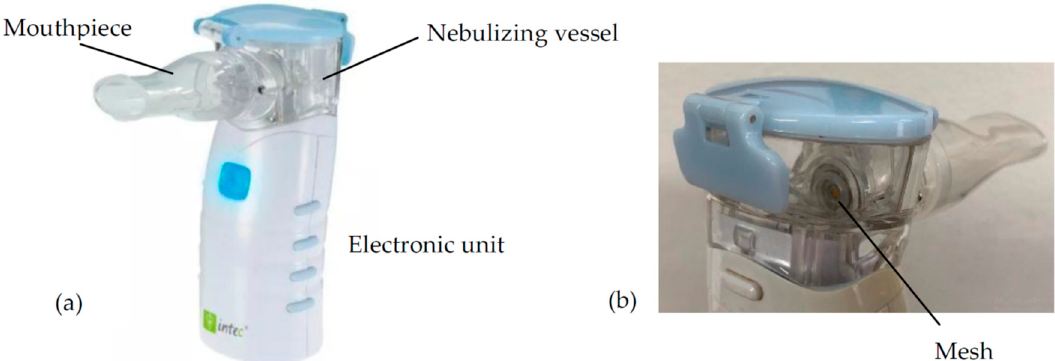
Figure 2. Intec Twister Mesh NE-105 nebulizer (VMN): ( a ) general view and ( b ) close-up of the nebulizing vessel (rear view).